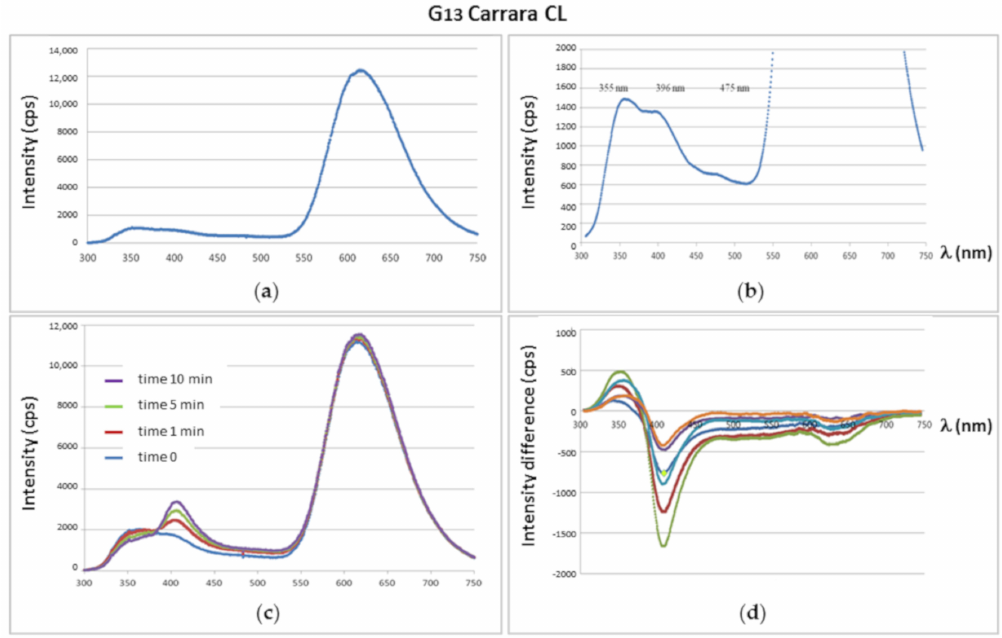
Figure 2. Experimental assay on a marble sample from Carrara (G13): ( a ) General CL emission spectrum; ( b ) detail of the UV peaks at 355, 396, and 475 nm; ( c ) temporal evolution of the spectrum under fixed spot and continuous bombardment; ( d ) associated representation of the di ff erences between the successive spectra over